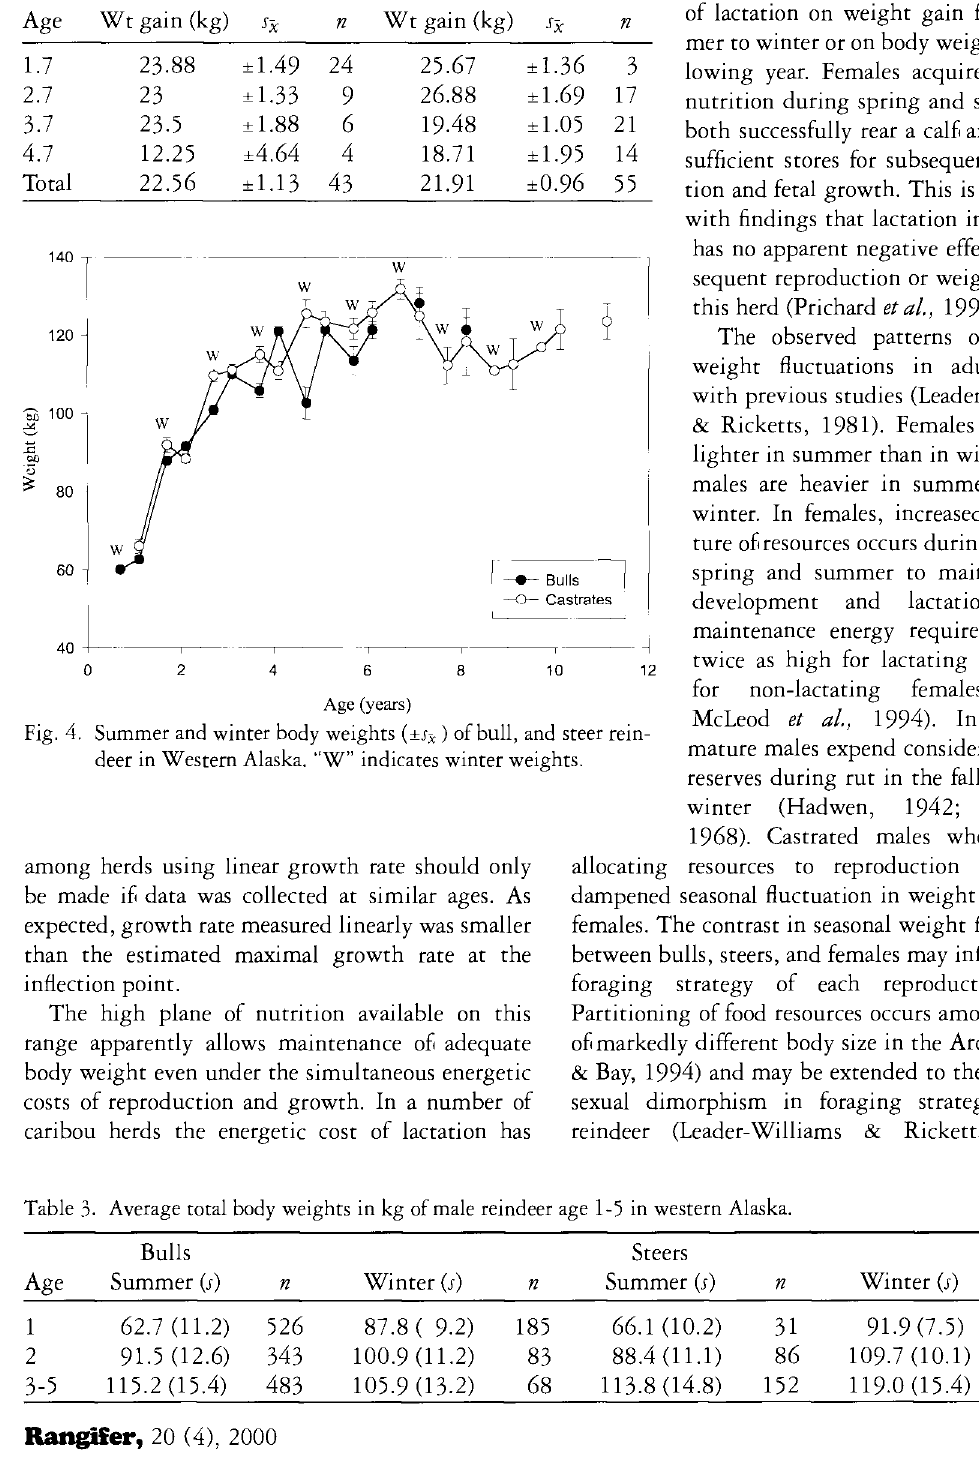
Table 3. Average total body weights in kg of male reindeer age 1-5 in western